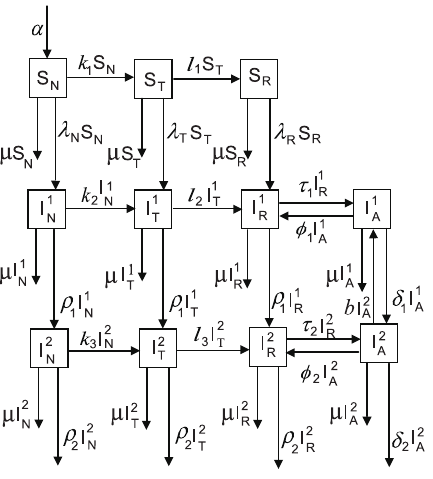
Figure 1. Schematic diagram of HIV combination prevention intervention model in the presence of ART. The top row of compartments show uninfected MSM who are S usceptible to HIV infection. They are divided into N on-testers, T esters, and testers